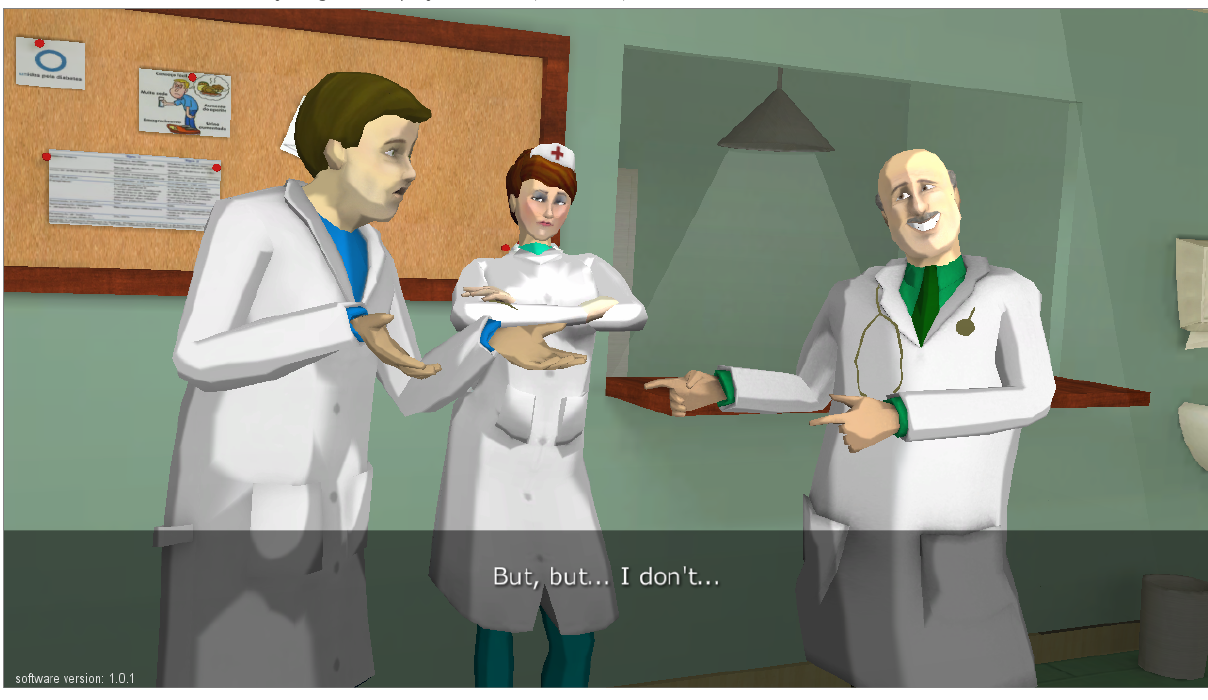
Figure 2. The main characters: the young doctor (player´s avatar), the nurse, and the older doctor (mentor).